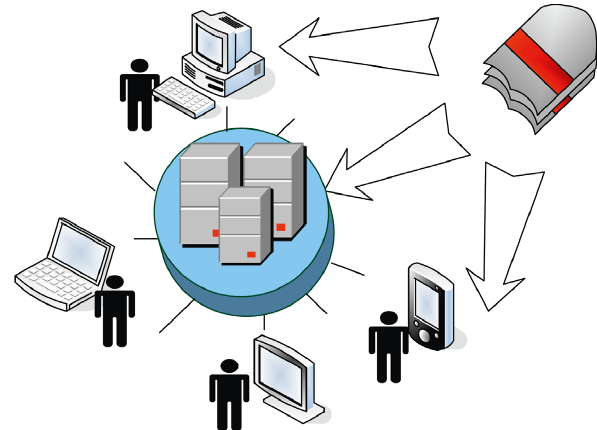
Figure 3: Application of SD card in electronic products.